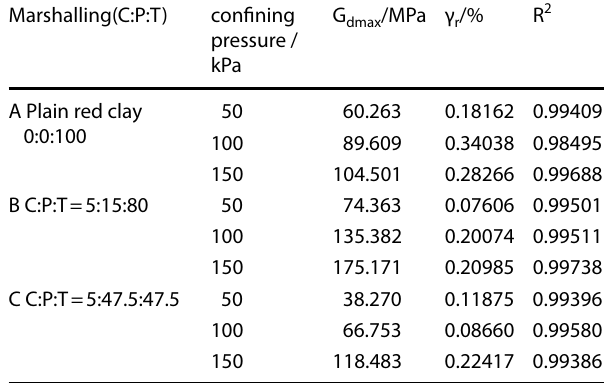
Table 7 Fitting parameters and correlation coefficients of dynamic shear modulus under different confining pressures